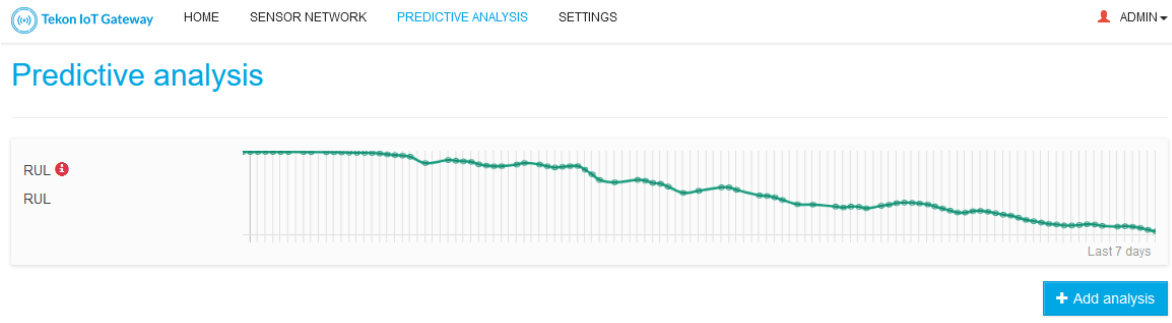
Figure 6. Predictive Analysis List. In this screen, the TIP4.0 web interface lists the available Predictive Analysis along with a summary of their output. In the example, only one Predictive Analysis is available, the RUL—Remaining Useful Life, and the graph depicts its evolution over time.